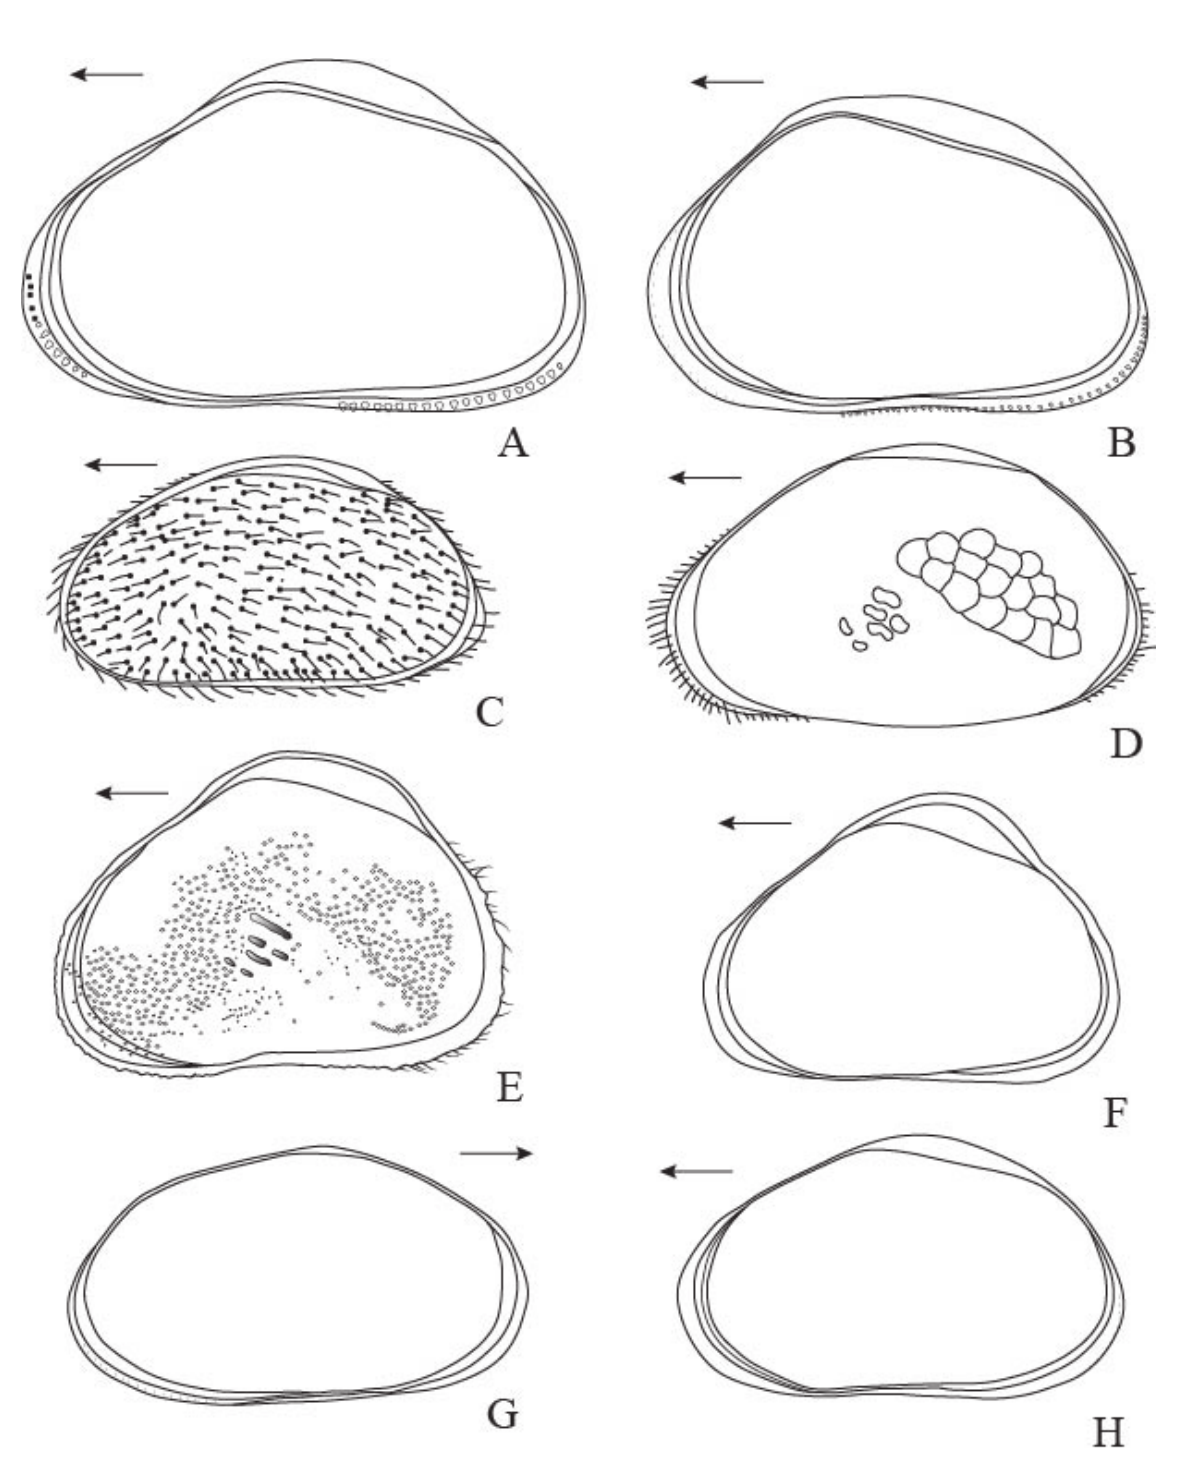
Fig. 8. Other species of Cyprinotus s. str. (redrawn from various sources, mostly the original descriptions, not to scale). A . Cyprinotus cingalensis Brady, 1886, RVi. B . C. edwardi McKenzie, 1978, RVi. C . C. indica Battish, 1981, CpLL. D . C. dahli Sars, 1896, CpLL. E . C. kimberleyensis McKenzie, 1966, RVi. F . C. scholiosus (Sohn & Morris, 1963), RVi. G . C. uenoi Brehm, 1936, LVi. H . C. uenoi Brehm, 1936, RVi. Arrows indicate anterior